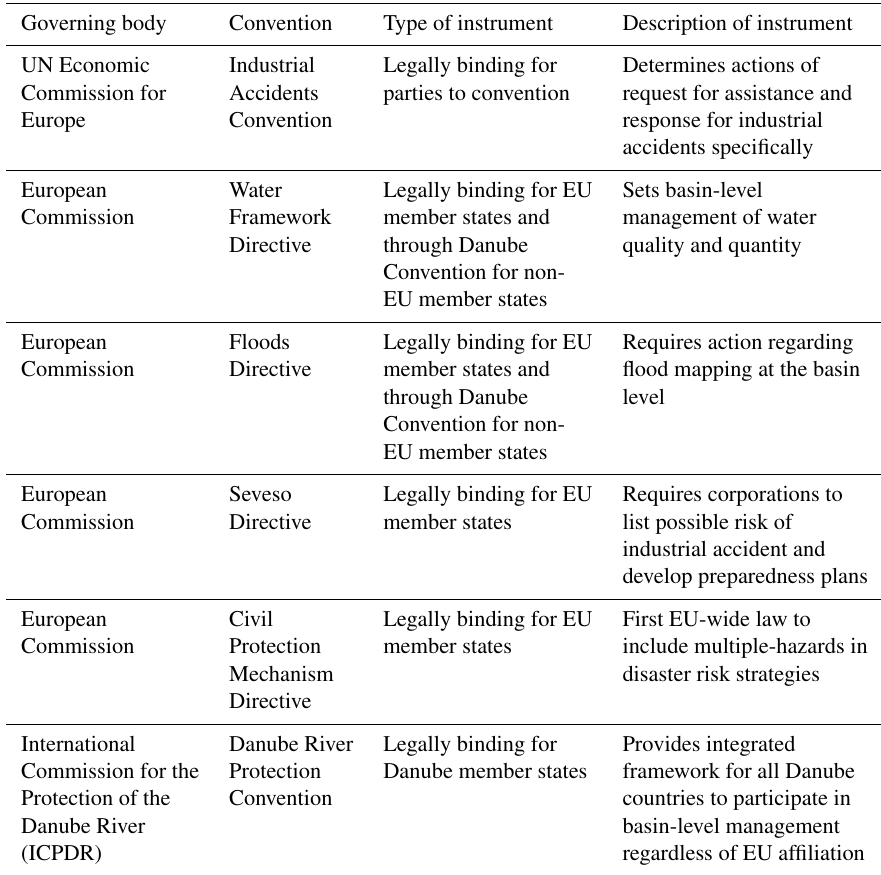
Table 1. List of legally binding mechanisms for the Danube basin and Tisza